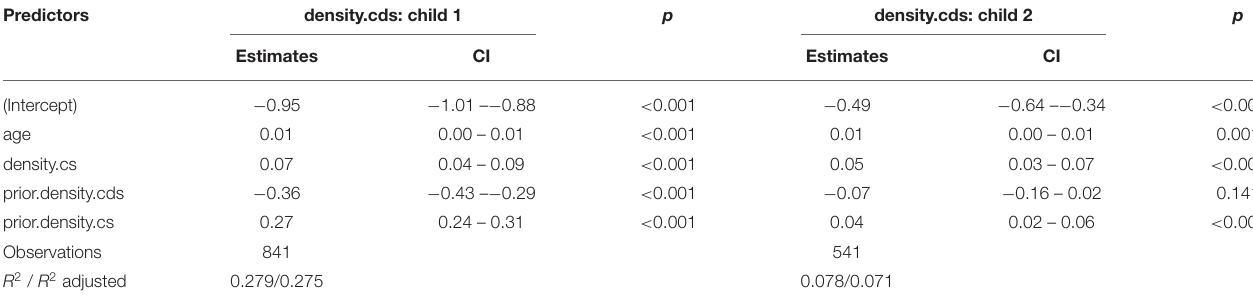
TABLE 11 | Linear model: CDS Network